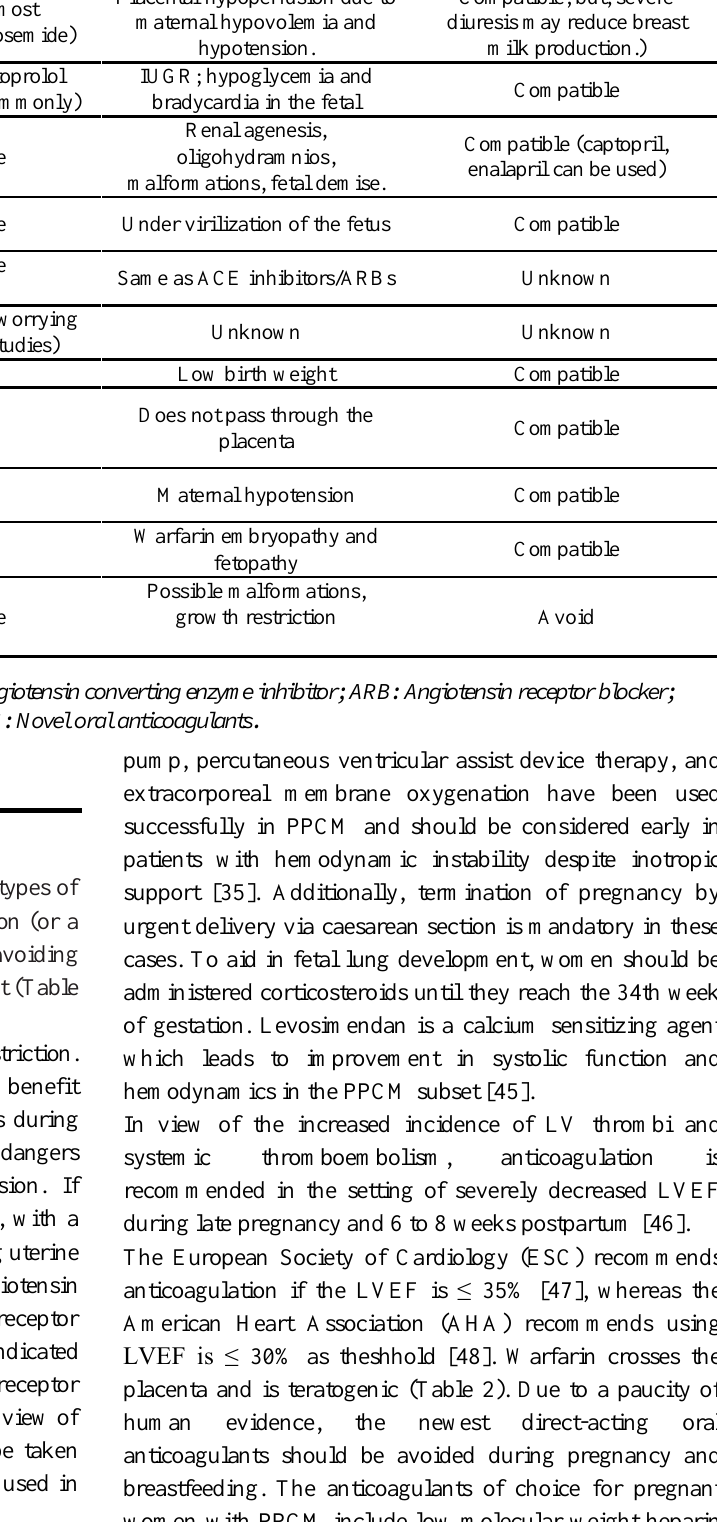
Table 2: Safety of medications for peripartum cardiomyopathy during pregnancy and lactation Medications During